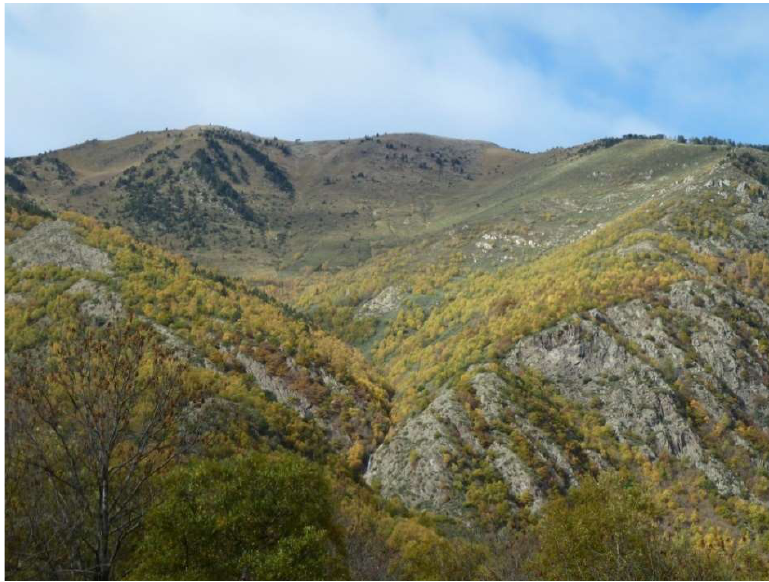
Figure 9. Vegetation in Monars catchment (autumnal view). Yellow colors from birches, brown from oaks, blackish green from mountain pine.